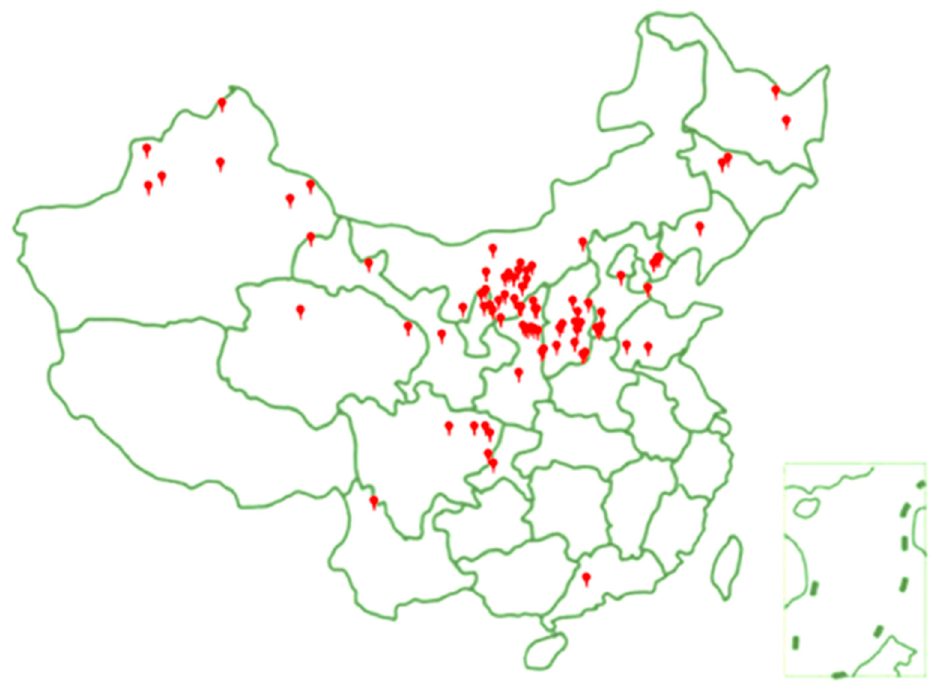
Figure 1. Distribution of natural gas liquefaction plants in China.